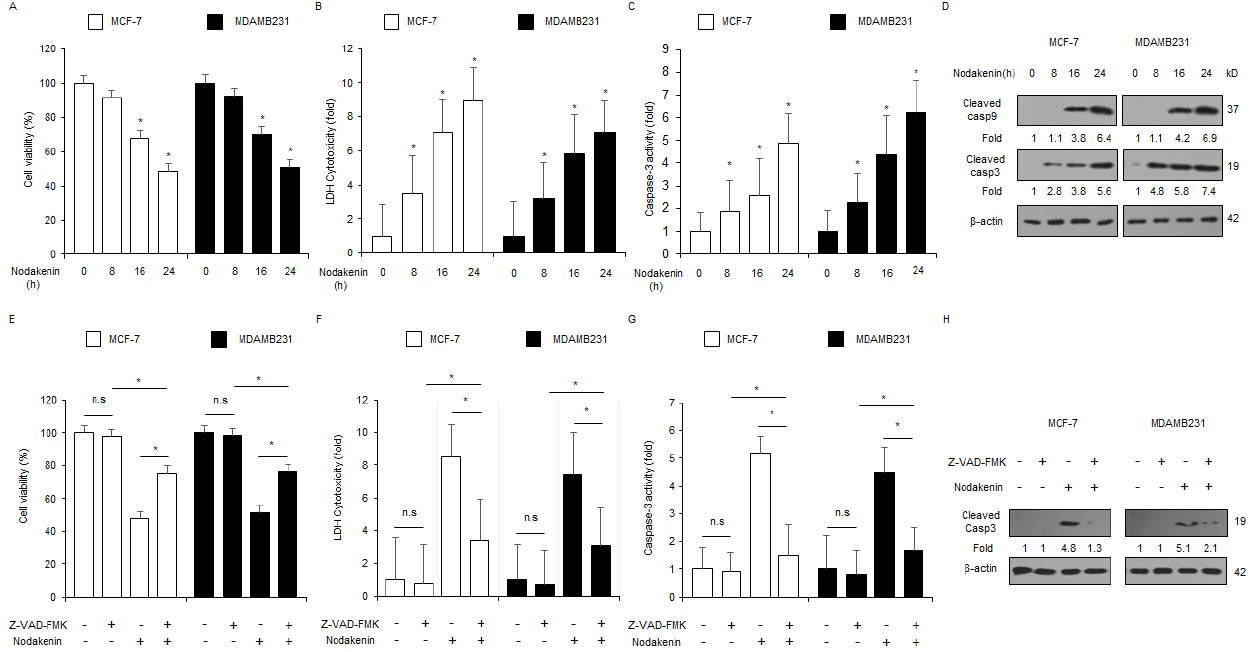
Figure 2. Nodakenin induces apoptosis and cell death in breast cancer cells. ( A – D ) After nodak- enin was treated at various time points in breast cancer cells (0, 8, 16, and 24 h; 40 µ M),